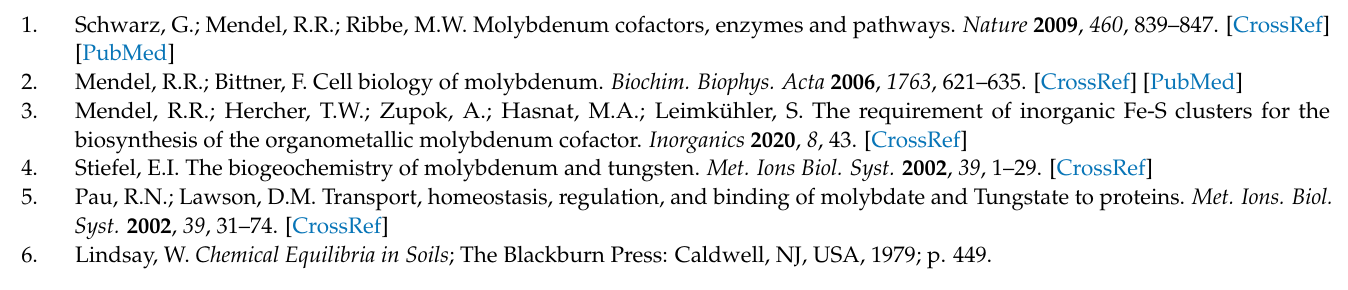
Figure S2: pH-dependent MolyProbe emission; Figure S3: Interference of N. crassa autofluorescence; Figure S4: Comparison of Mo measurements by the MolyProbe assay with